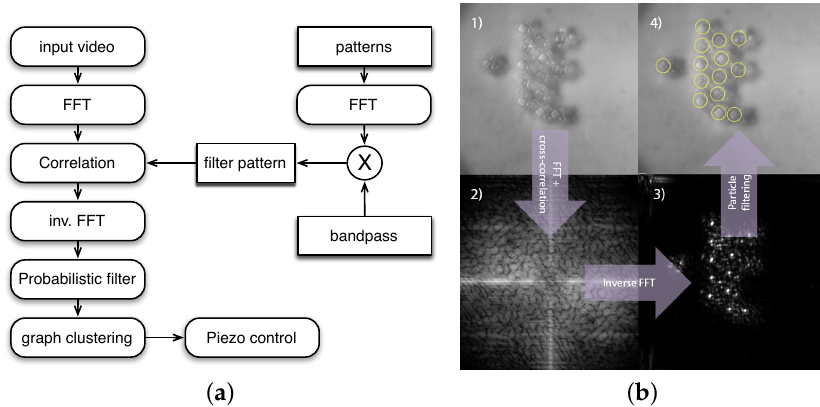
Figure 8. ( a ) Diagram of the particle tracking system in the SelfSys. The generation of the filter pattern is run only once, thus it does not contribute to the total processing time during operation [10]; ( b ) Image processing steps in the SelfSys: ( 1 ) captured input image; ( 2 ) bandpass-filtered cross-correlation (Fourier domain); ( 3 ) matching result after inverse Fourier transform and probabilistic filtering; ( 4 ) final tracking displayed on the input image [10].